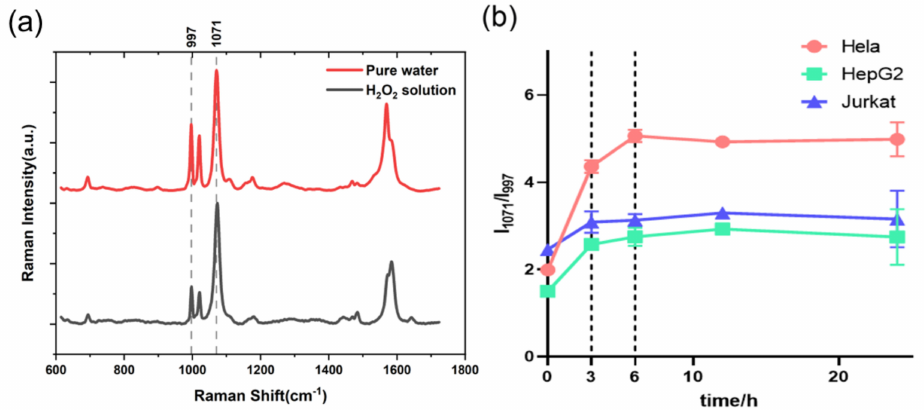
Figure 3. ( a ) Raman spectra of the SERS boric acid nanoprobe measured in H 2 O 2 solution and pure water solution without H 2 O 2 ; ( b ) the change in Raman peak intensity ratio I 1071 /I 997 of three types of cells versus